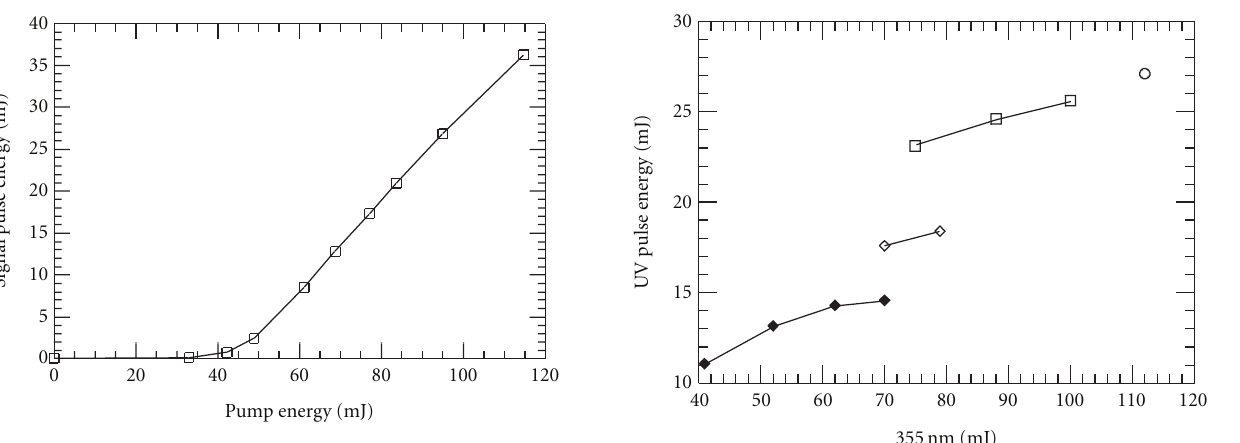
Figure 2: Measured OPO signalenergy as function of pump energy.